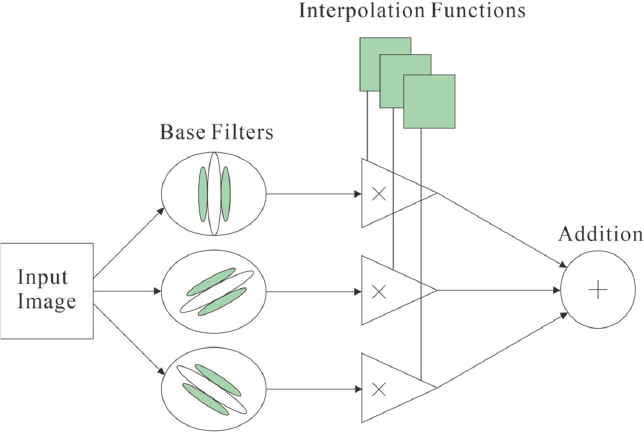
Figure 5. Schematic diagram of the structure and processing process of the direction-controllable